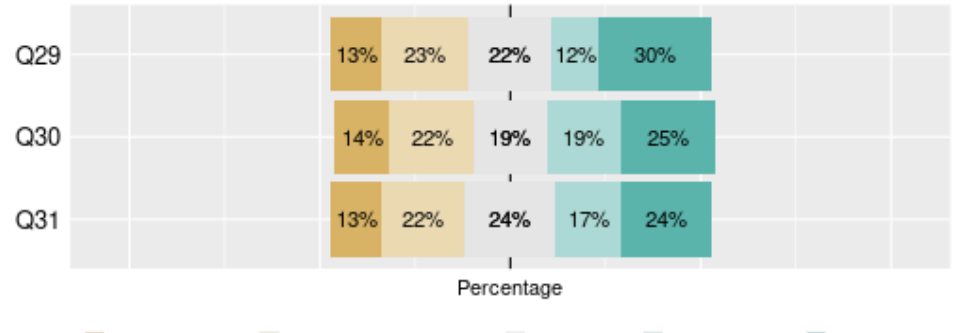
Figure 6. Results related to Data Traceability dimension.